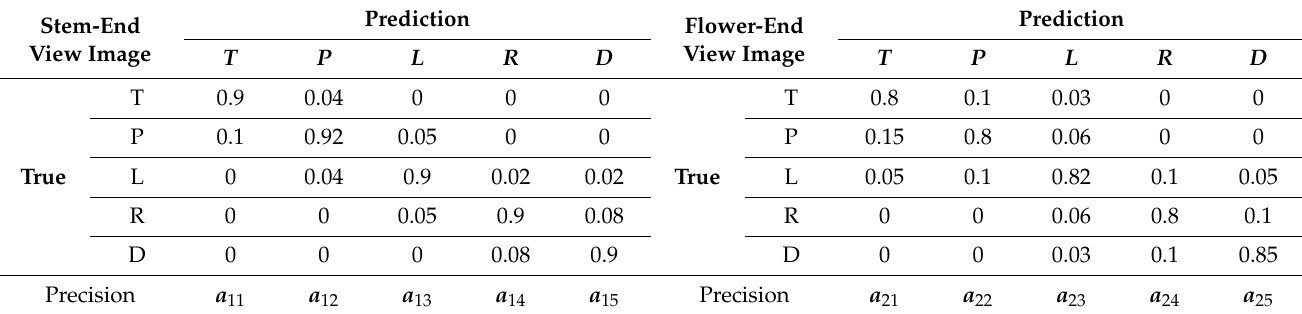
Table 2. Example of multi-label confusion matrices for ConvNet streams with stem-end view input (left) and flower-end view input (right). (T: Turning, P: Pink, L: Light Red, R: Red, D: